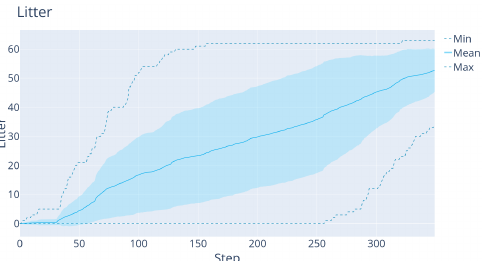
Figure 14. The results with the LM agent on 32 × 32 × 24 maps with the 15 × 3 sensor.